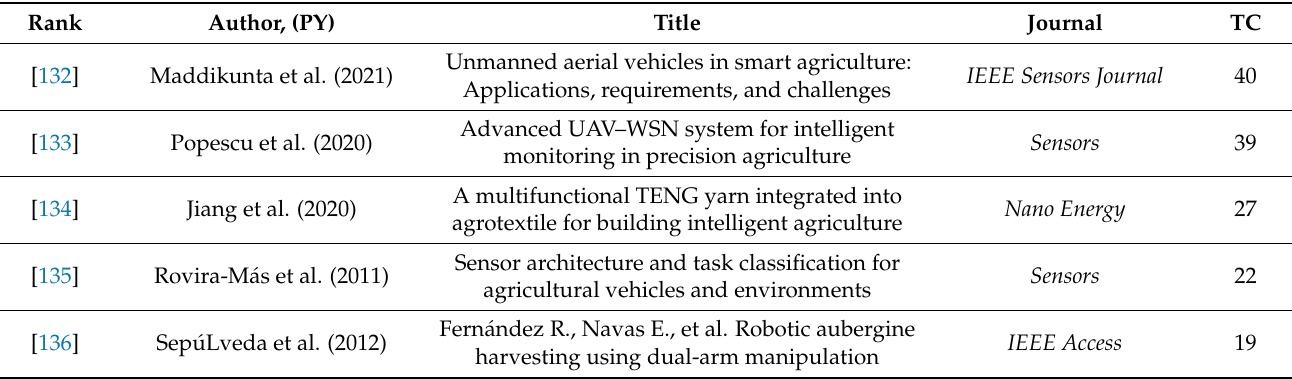
Table 7. Impact analysis of relevant